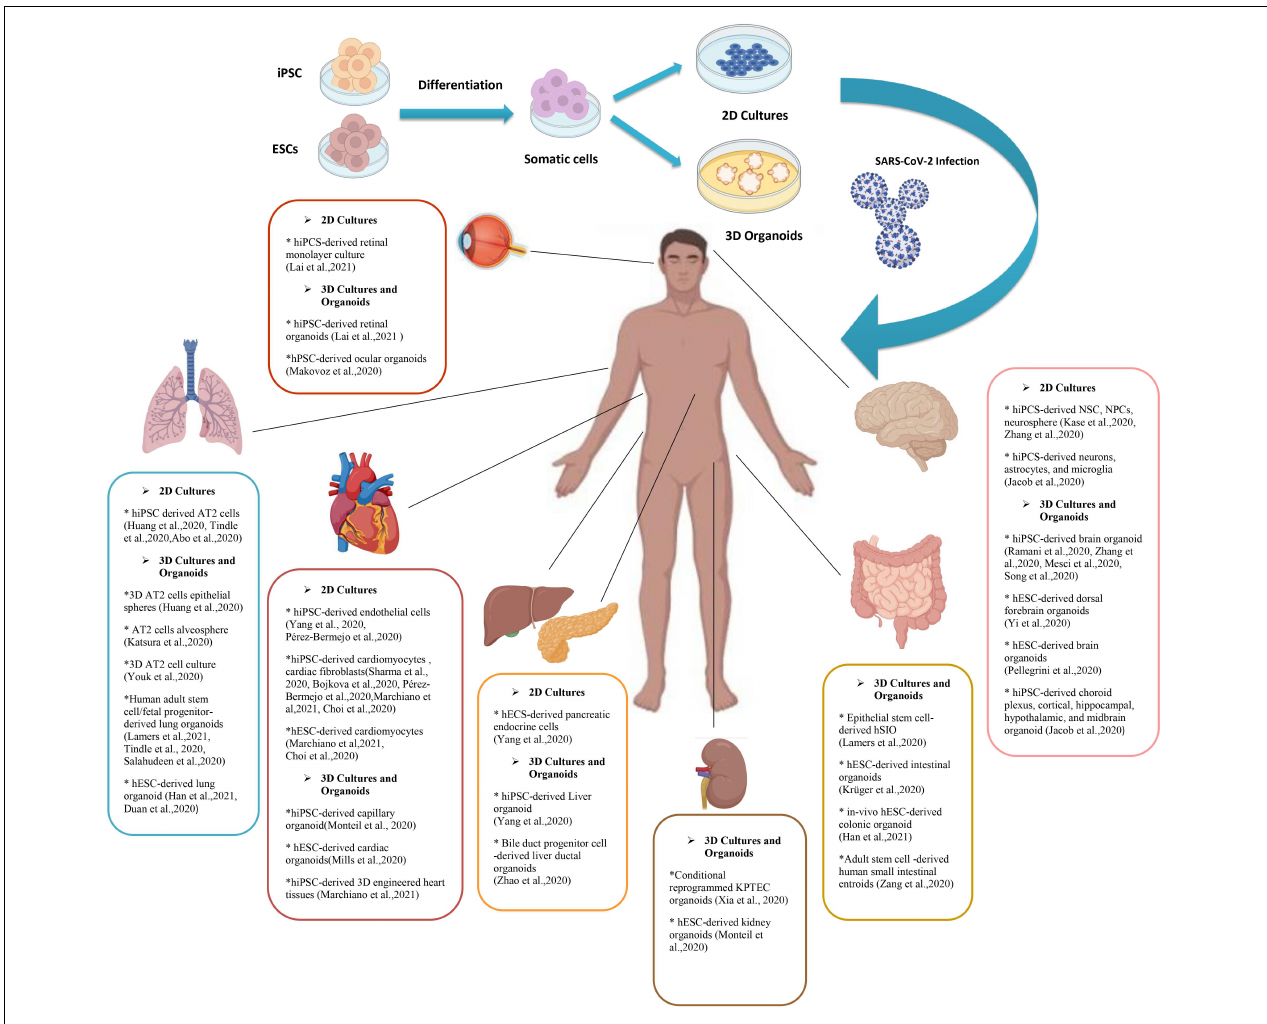
FIGURE 1 | A Summary of pluripotent stem cell (PSC) derived 2d and 3D models of SARS-CoV-2 infection. Human induced pluripotent stem cells (hiPSCs) and human embryonic stem cells (hESCs) have been used to produce adult somatic cells of different organs. Culturing these cells can become either 2D models of the cells or tissue or the novel model of 3D organoids. Various studies have used PSCs (and some adult stem cells) to investigate the SARS-CoV-2 infection mechanism and its manifestations. This figure provides a brief review of currently available researches on different stem cell-based models to discover the SARS-CoV-2 mechanism of action and potential therapeutic strategies. PSCs, Pluripotent stem cell; hESCs, Human embryonic stem cells; hiPSCs, Human induced pluripotent stem cells; SARS-CoV-2, Severe acute respiratory syndrome Coronavirus-2; NSCs, Neural stem cells; NPCs, Neural progenitor cells; AT2s, Type2 alveolar epithelial; 2/3-D, 2/3 dimensional; KPTECs, Kidney proximal tubule epithelial cells; hSIO, Human small intestinal